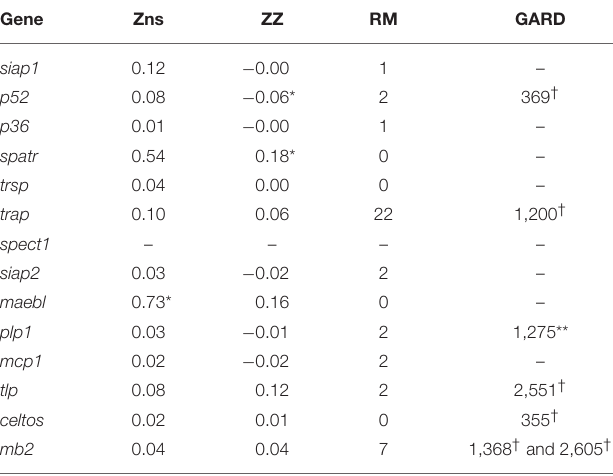
TABLE 4 | LD and intra-gene recombination